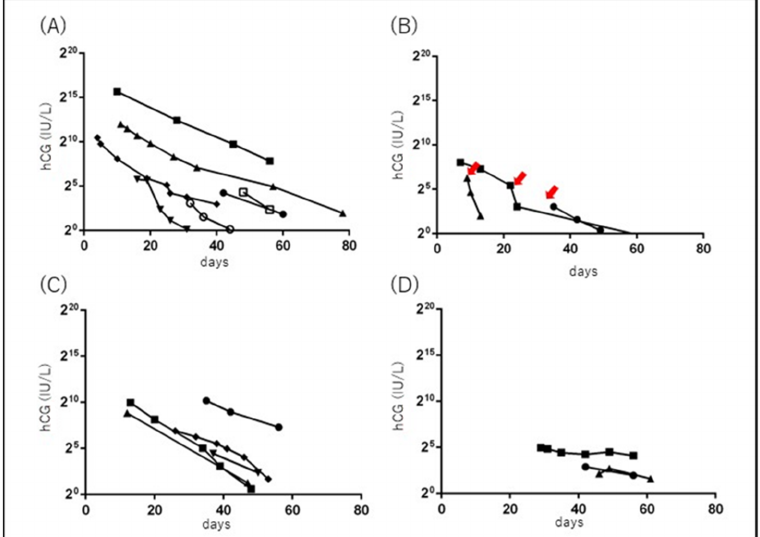
Figure 8. Serial changes in serum hCG. The horizontal and vertical axes indicate the duration from delivery to the measurement date (days) and the serum hCG level (IU/L), respectively. ( A , B ) RPOC cases delivered after 34 weeks of gestation. ( A ) Cases without UAE. ( B ) Cases with UAE. Arrows show the date on which UAE was performed. ( C , D ) RPOC cases delivered at less than 20 weeks of gestation and did not undergo UAE. ( C ) Cases with serum hCG half-life of less than 10 days. ( D ) Cases with serum hCG half-life of more than 10 days. RPOC: retained products of conception; UAE: uterine artery embolization; hCG: human chorionic gonadotropin.